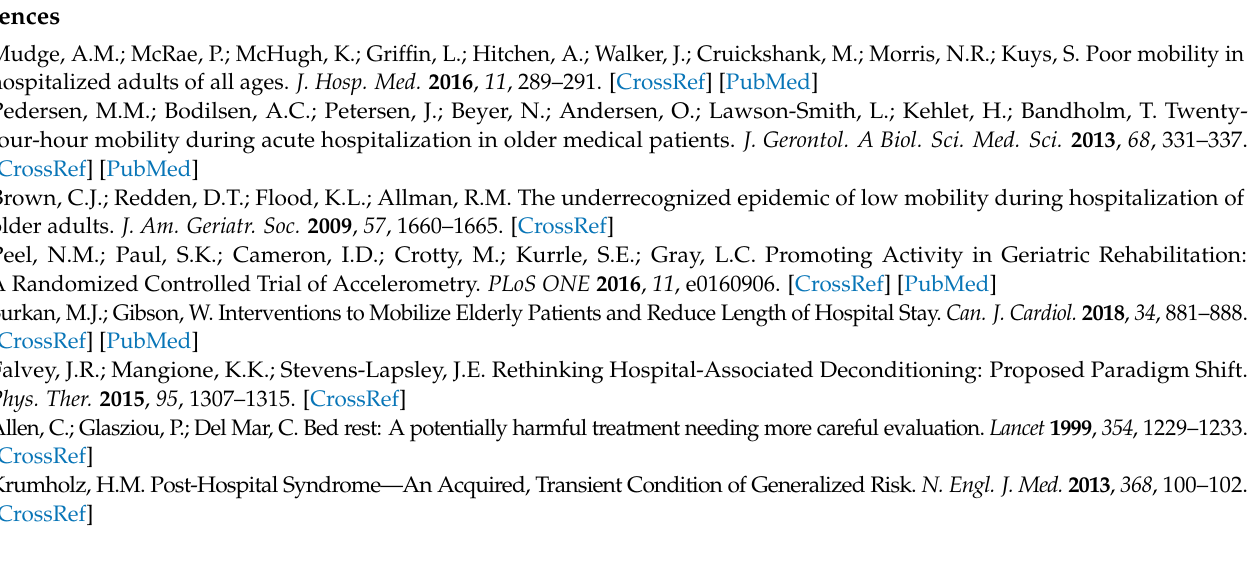
January 2020 Table S2: TiDieR checklist Brown et al. Table S3: TiDieR checklist Dall et al. Table S4: TiDieR checklist Killey and Watt. Table S5: TiDieR checklist McGowan et al. Table S6–S9: Completed Risk of Bias-2